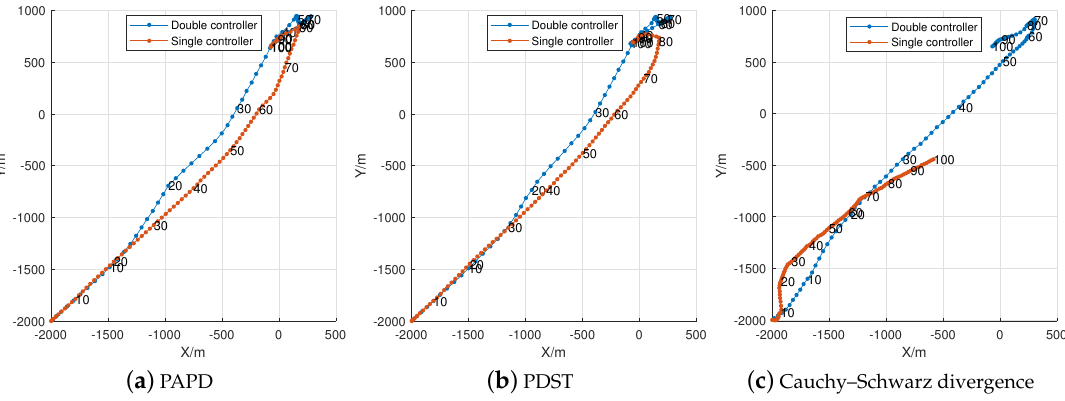
Figure 8. The expected trajectory of sensor (100 Monte Carlo